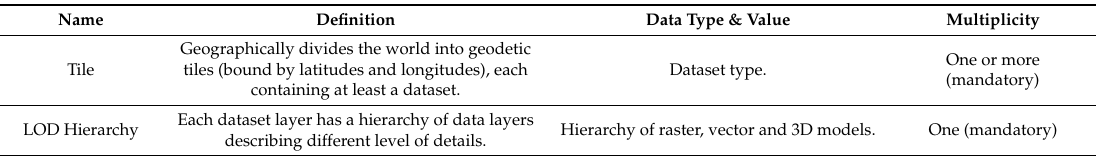
Table 1. The main properties of Unified Modeling Language (UML) Package diagram of the Open Geospatial Consortium (OGC) CDB datastore.